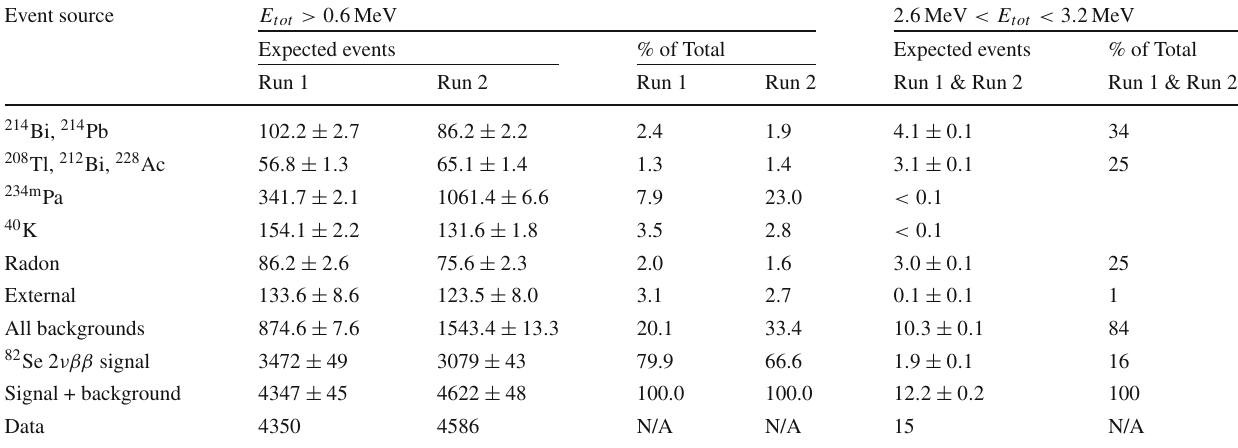
Table 2 Predicted number of events in the two electron channel for different event sources. The expected numbers of events in the energy region relevant to 0 νββ are also given. Isotopes denote the internal con- taminations of the 82 Se foils and the numbers are assigned to whether